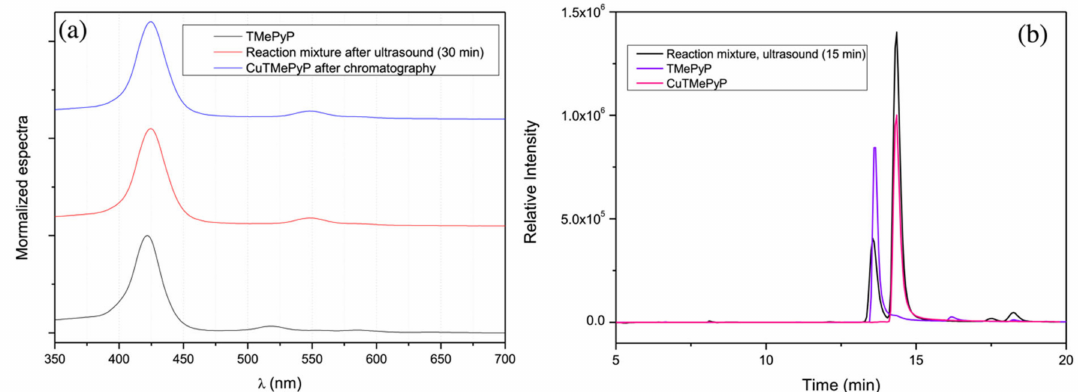
Figure 4. ( a ) Normalized UV-Vis spectra of free porphyrin, TMePyP (black), the reaction crude after 30 min under ultrasound -TMePyP and 1 equivalent of Cu(OAc) 2 · H 2 O in 1 mL of water-(red) and the copper complex CuTMePyP after purification through exclusion chromatography (blue) ( b ) HPLC chromatograms of the reaction crude -TMePyP and 1 equivalent of Cu(OAc) 2 · H 2 O in 1 mL of water after 30 min under ultrasound (black) compared with the free porphyrin TMePyP (blue) and the copper complex CuTMePyP after isolation and purification through exclusion chromatography (pink).